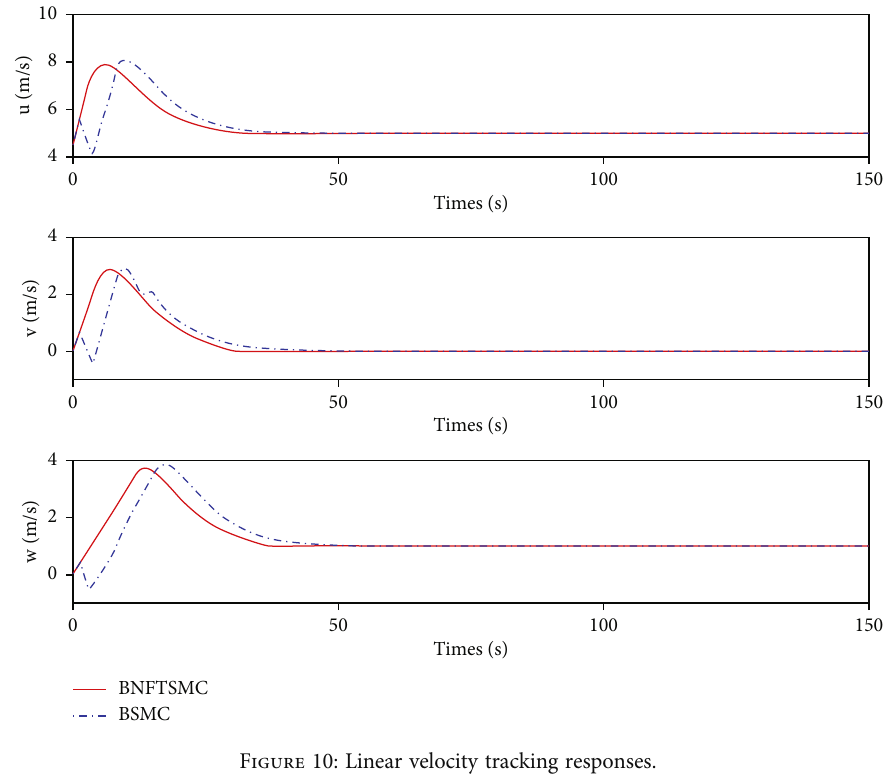
Figure 10: Linear velocity tracking